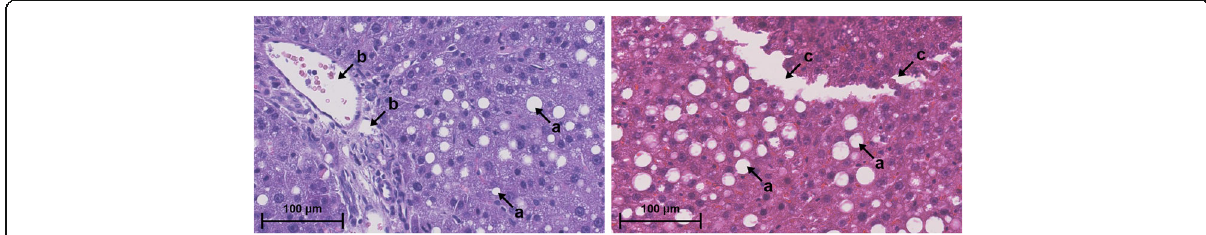
Fig. 1 Appearance of steatosis. In histological sections, macrovesicular steatosis appears as white fat droplets ( a ) in the cytoplasm of hepatocytes. They must be distinguished from other white structures like vessels ( b ) or tissue cracks ( c )